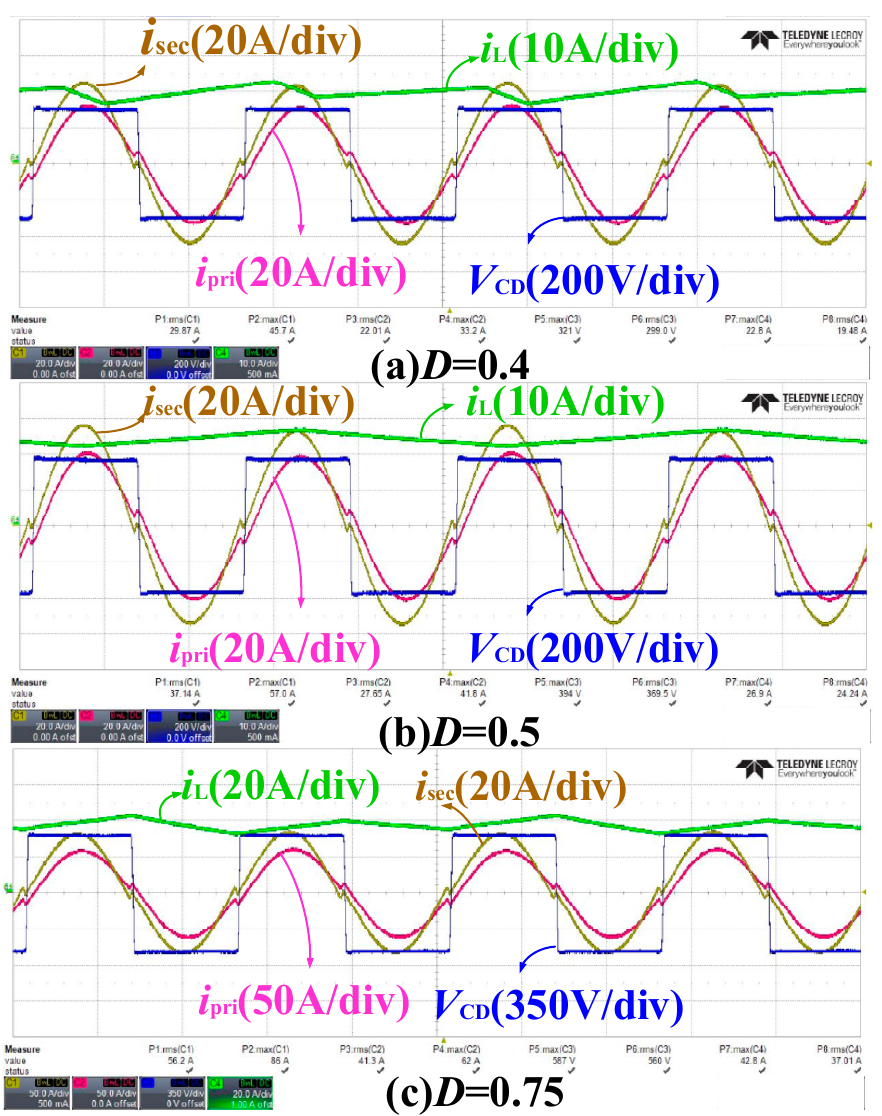
Figure 20. Experimental results of the back-end HFI LLC resonant converter ( a ) D = 0.4; ( b ) D = 0.5; ( c ) D = 0.75.